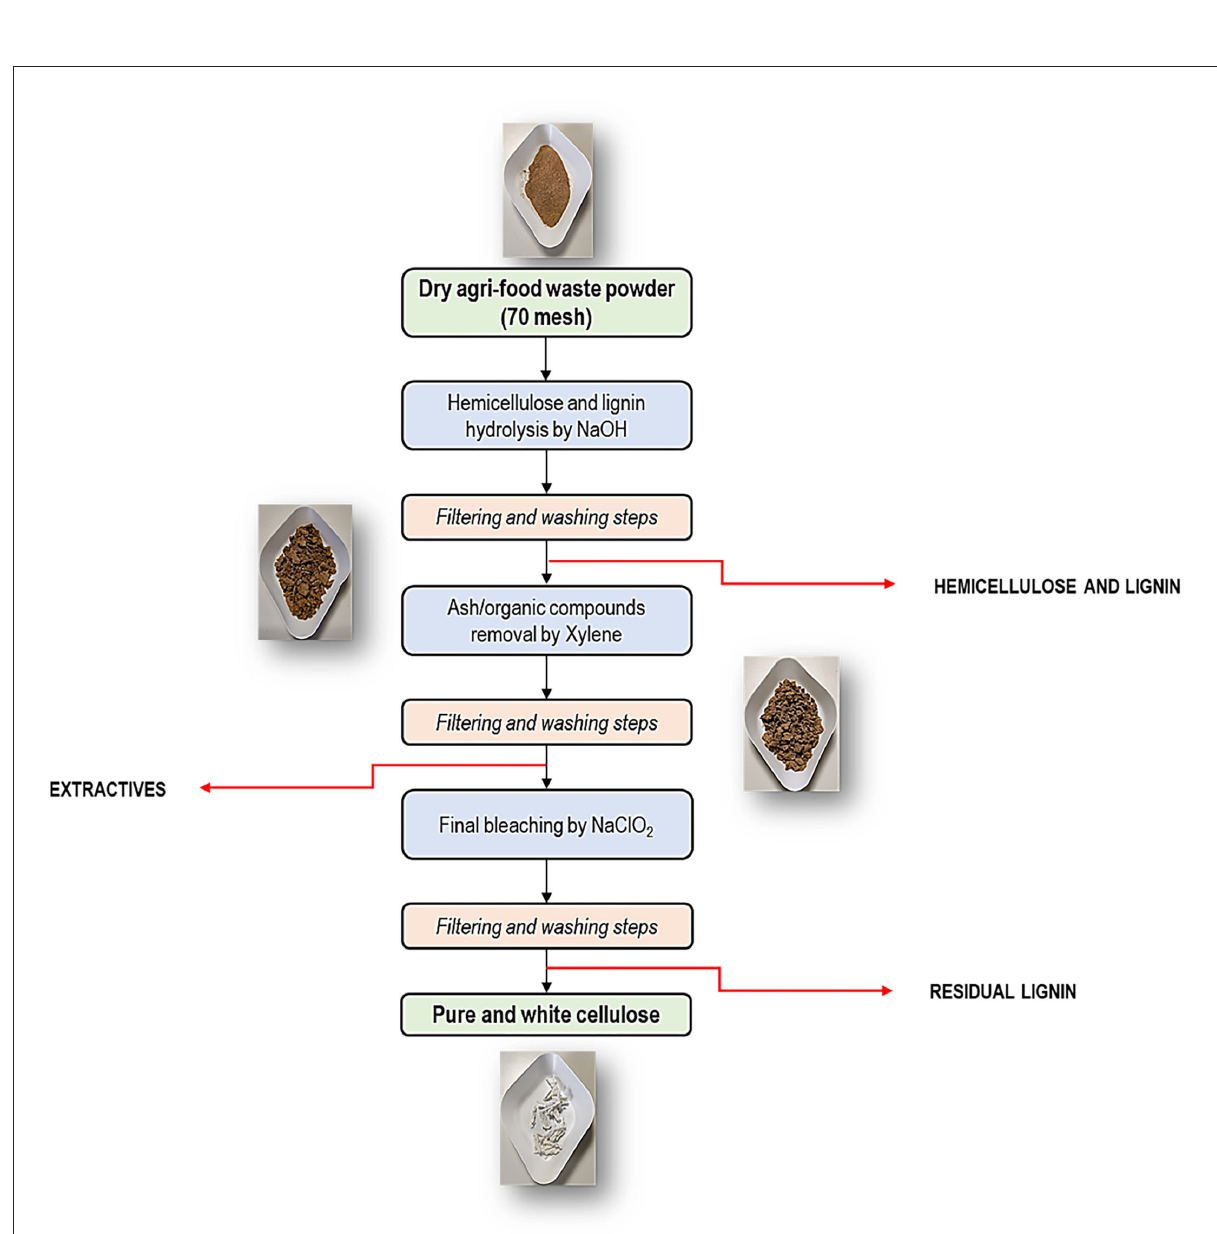
FIGURE1 Schematic representation of the extraction protocol of cellulose from agro-waste feedstocks used in this work. Please refer to the main text for details.